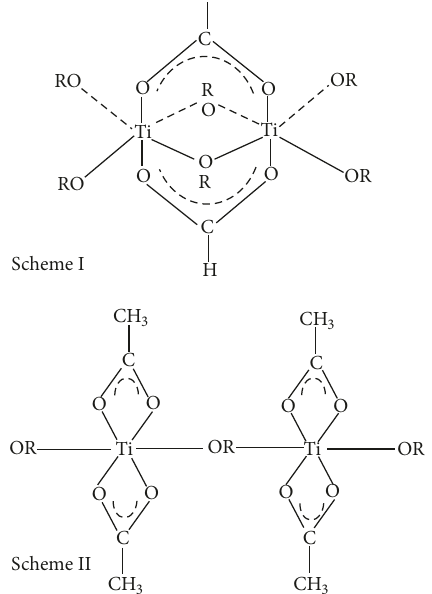
Figure 4: Proposed schemes of (I) formate group and (II) acetate group chelation with titanium